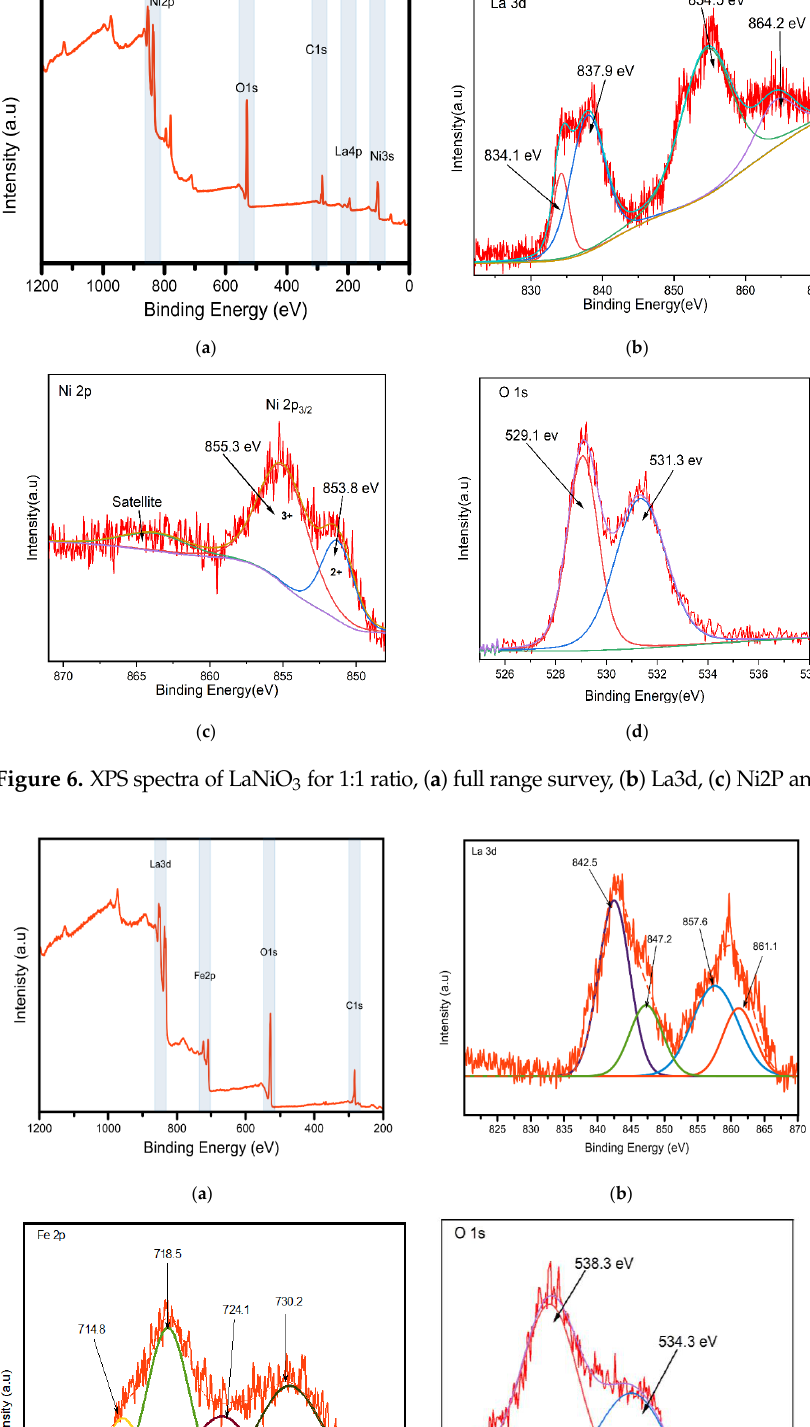
Figure 5. XPS spectra of LaCoO 3 for 1:1 ratio, ( a ) full range survey, ( b ) La3d, ( c ) Co2P, and ( d ) O1s spectra.